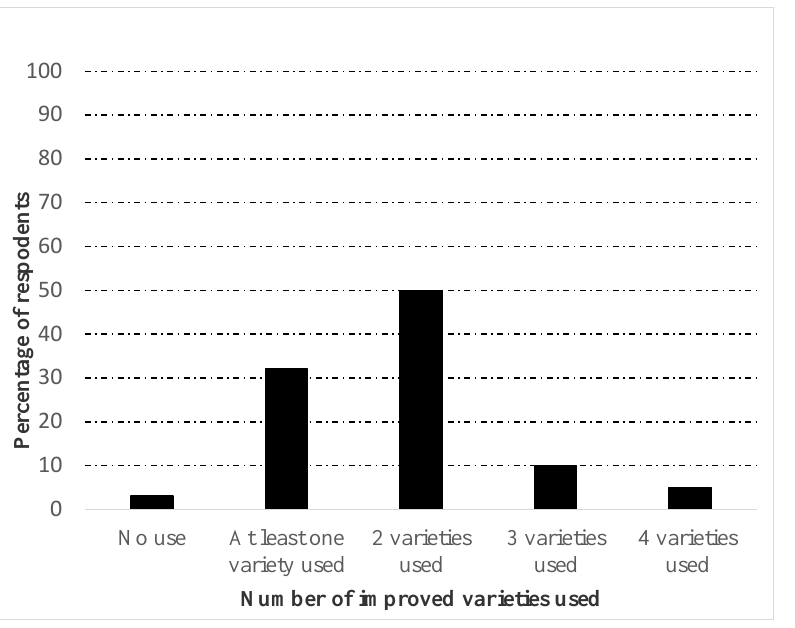
Figure 11. Use of improved sorghum varieties in Yaguine, Gory, and Foungou, from the 2013/2014 to the 2020/2021 cropping seasons.